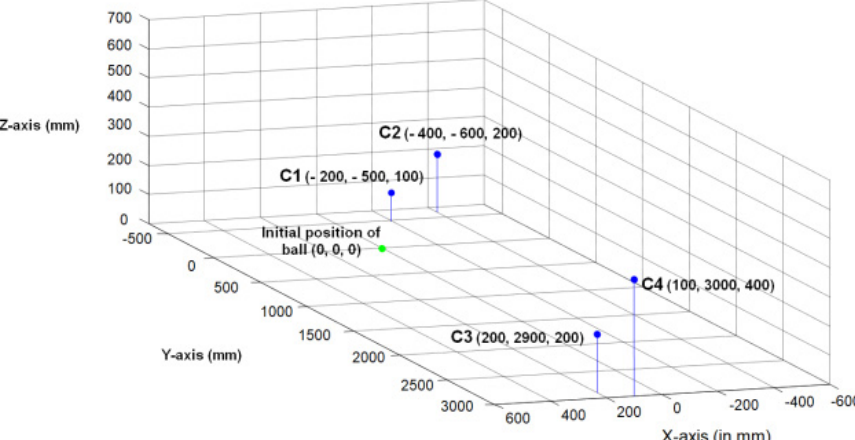
Figure 6. Identified best capturing cameras positions.